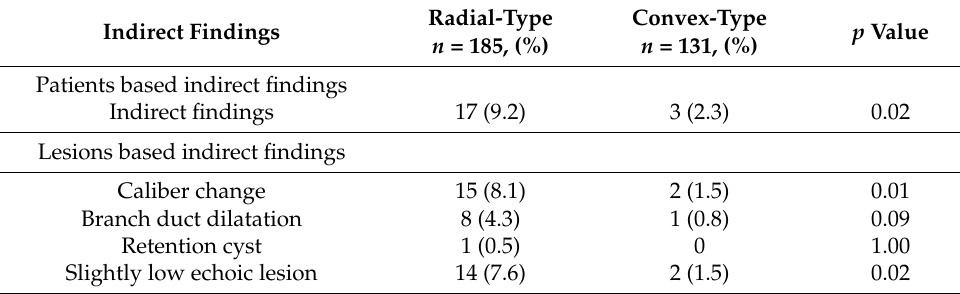
Table 2. Indirect findings between radial-arrayed and convex-arrayed